Question: Write a single sentence explaining what this figure depicts.
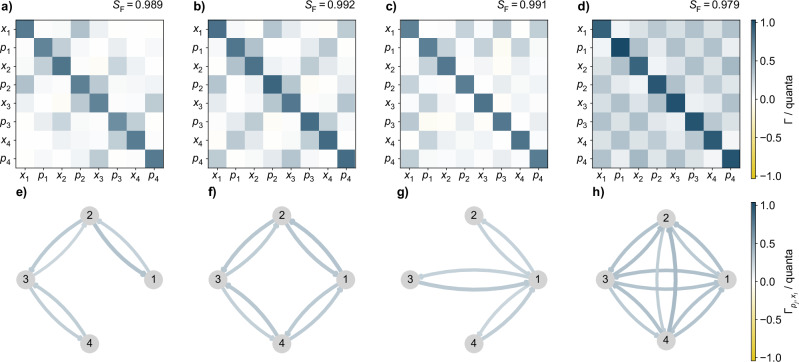
Answer: Quadrature covariance matrices and inferred graph connectivity. a – d Reconstructed covariance matrix Γ of the quadrature operators at P p = −24 dBm, extracted from heterodyne detection of four frequency modes clustered in linear ( a , e ), cyclic ( b , f ), star ( c , g ), and fully-connected ( d , h ) configurations. e – h Evaluation of the graph connectivity inferred from the elements of the covariance matrix, with the color of the arrow pointing from the j -th to the l -th node mapping the value of the \documentclass[12pt]{minimal} \usepackage{amsmath} \usepackage{wasysym} \usepackage{amsfonts} \usepackage{amssymb} \usepackage{amsbsy} \usepackage{mathrsfs} \usepackage{upgreek} \setlength{\oddsidemargin}{-69pt} \begin{document}$${\Gamma }_{{p}_{j},{x}_{l}}$$\end{document} Γ p j , x l term.